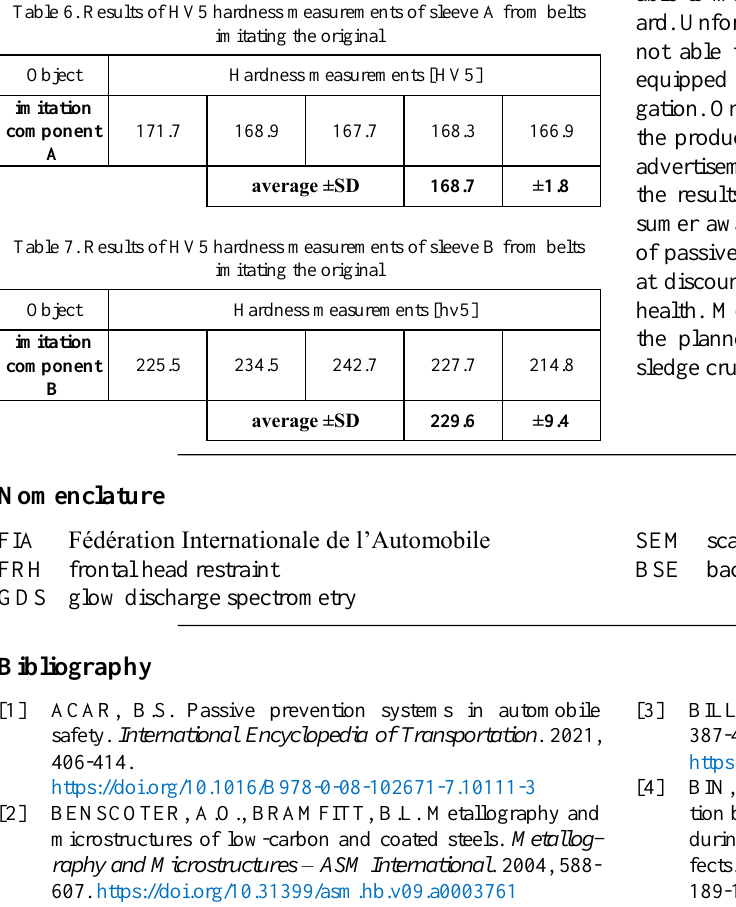
Table 5. Results of HV5 hardness measurements of sleeve from original Object Hardness measurements [HV5] original component